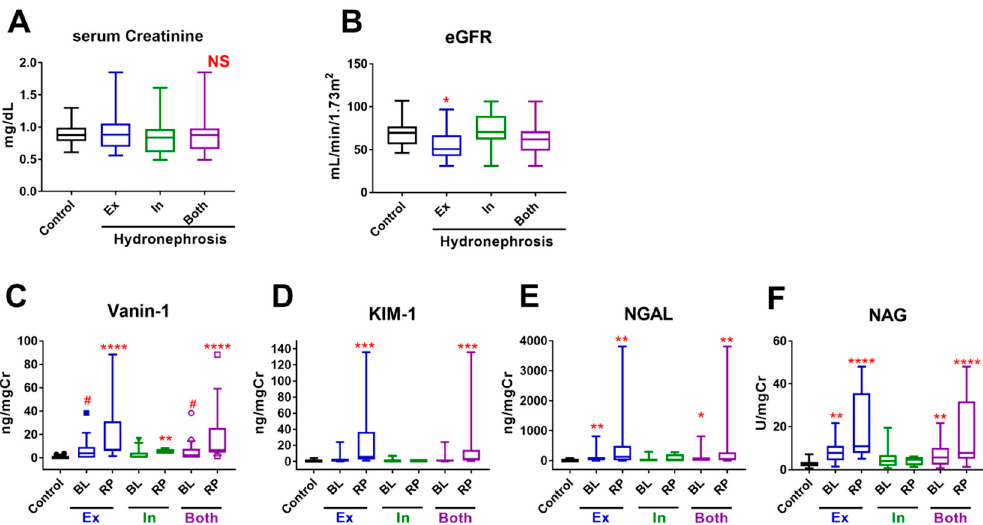
Figure 2. Renal functions and AKI biomarkers in the control versus hydronephrosis group. ( A, B ) The serum levels of creatinine ( A ) and eGFR ( B ) in the control and hydronephrosis groups (control, black; extrinsic UUTO, blue; intrinsic UUTO, green; all UUTO, purple). ( C – F ) The levels of vanin-1 ( C ), KIM-1 ( D ), NGAL ( E ), and NAG ( F ) in the bladder and renal pelvic urine in the hydronephrosis group (extrinsic UUTO, blue; intrinsic UUTO, green; and all UUTO, purple) were compared to the levels of each biomarker in the bladder urine of the control group (black). Data were analyzed using the Mann-Whitney U test ( A ), t -test ( B ), and the Kruskal-Wallis test with Dunn’s multiple comparisons test ( C – F ). # p < 0.1, * p < 0.05, ** p < 0.01, *** p < 0.01 **** p < 0.0001 vs. control. Ex, extrinsic UUTO; In, Intrinsic UUTO; NS, not significant.